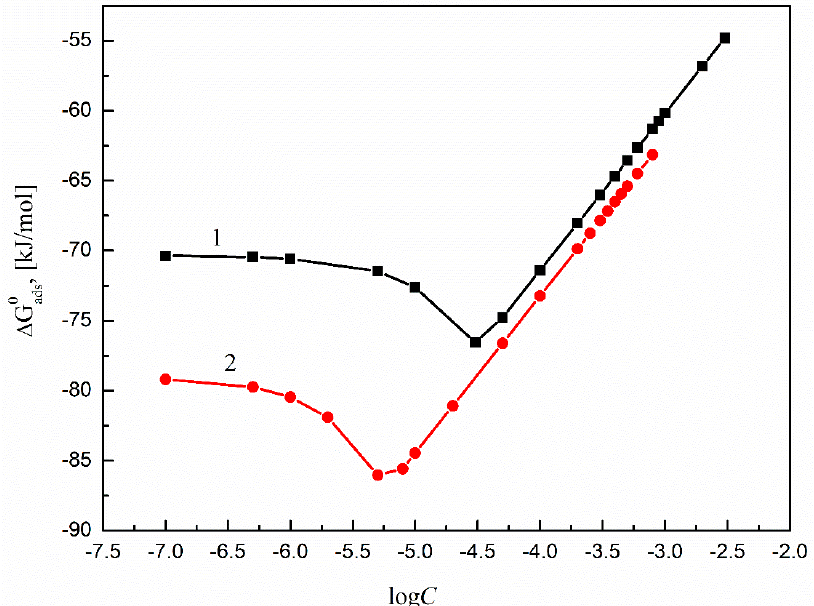
Figure 7. A plot of the standard Gibbs free energies of adsorption ( ∆ G 0 SML (curve 2) at the Ti6Al4V ELI–water interface vs. the logarithms of surfactant concentration (log C S ) calculated from Equation (9).